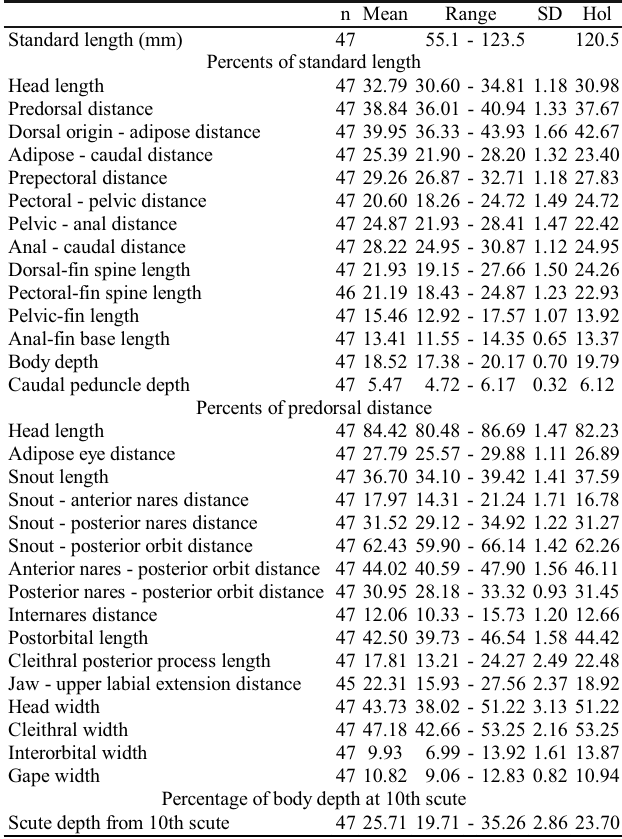
Table 1. Morphometric data for Leptodoras oyakawai (Hol =